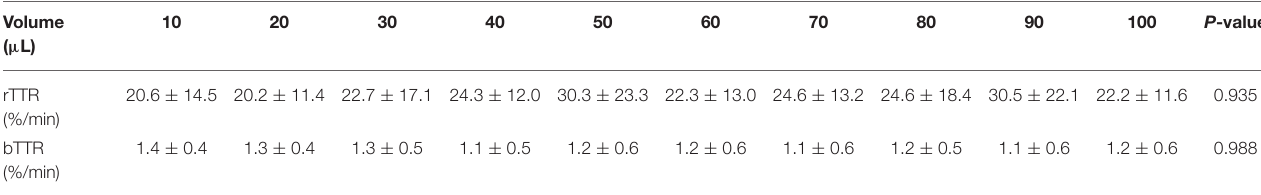
TABLE 1 | Mean ± standard deviation of reflex tear turnover rate (rTTR) and basal tear turnover rate (bTTR) in 8 Beagle dogs following topical instillation of 10–100 µ l of 0.1% fluorescein solution in each